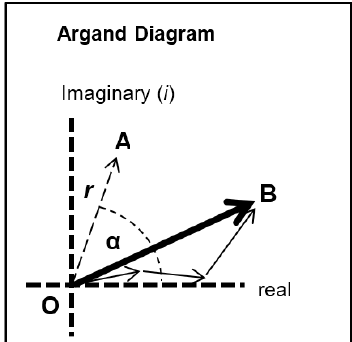
Figure 7. Diagram illustrating the addition of vectors in an Argand diagram. Here any vector such as OA has an amplitude (the arrow length) and a phase ( α ). In the muscle case for each equatorial reflection each crossbridge state will contribute a vector (the smaller arrows) which will add vectorially to give the resultant OB. If the structure is centrosymmetric then the arrows will all point along the horizontal (real) axis (their phase is 0° or 180°) and they just need to be added or subtracted.